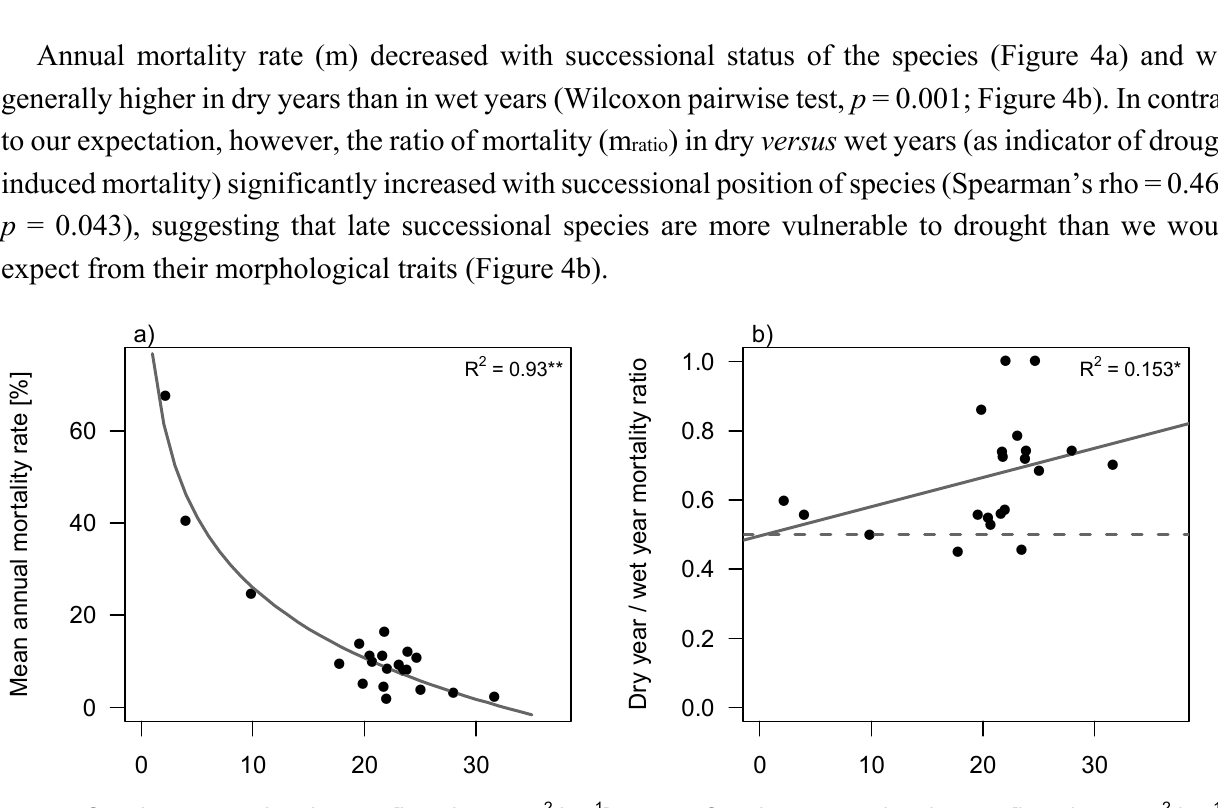
Figure 4. Mortality rate of tree species against their successional status. Successional status was defined as the abundance weighted average basal area of the plots where the species was found. ( a ) Mean annual mortality rate, calculated over 10 years (2001–2010); ( b ) Ratio of dry year mortality, relative to wet year mortality, calculated over the three wettest and three driest years. The 0.5 line represents equal mortality in wet and in dry years. Values above the 0.5 line correspond to higher mortality in dry years than in wet years. Values below the line correspond to lower mortality in dry years than in wet years. Carried out with Spearman’s rank